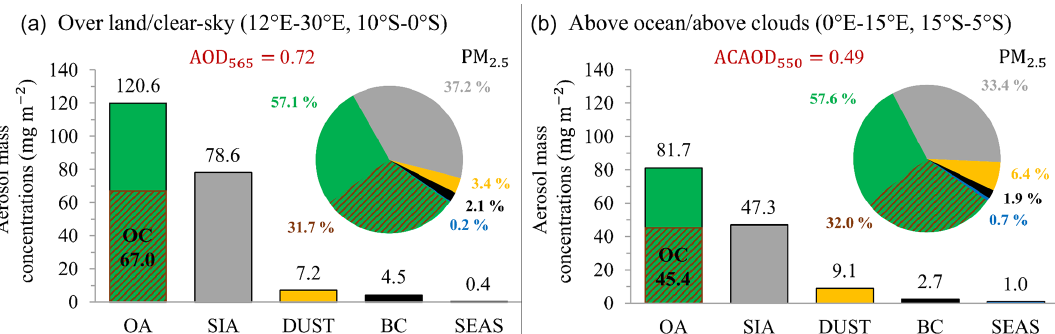
Figure 12. Evolution of the PM 2 . 5 chemical composition simulated with the WRF-Chem partially constrained configuration between the southern African continent in clear sky (12–30 ◦ E, 10–0 ◦ S, a ) and the southeastern Atlantic Ocean above clouds (0–15 ◦ E, 15–5 ◦ S, b ). Mass concentrations (in mgm − 2 ) of the main aerosol compounds of biomass burning, i.e. black carbon (BC, black), organic carbon (OC, brown hatching), organic aerosols (OA, green), and secondary inorganic aerosols (SIA, grey), as well as desert dust aerosols (DUST, yellow) and sea salt aerosols (SEAS, blue), are vertically integrated over the atmospheric column on average for July